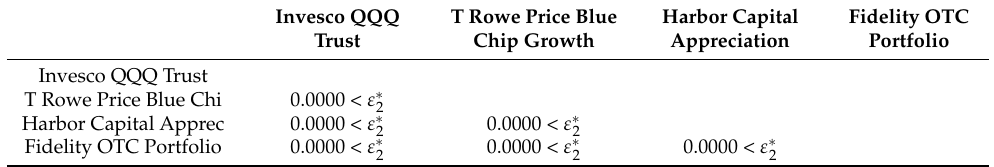
Table 4. Almost Second Stochastic Dominance (ASSD) test